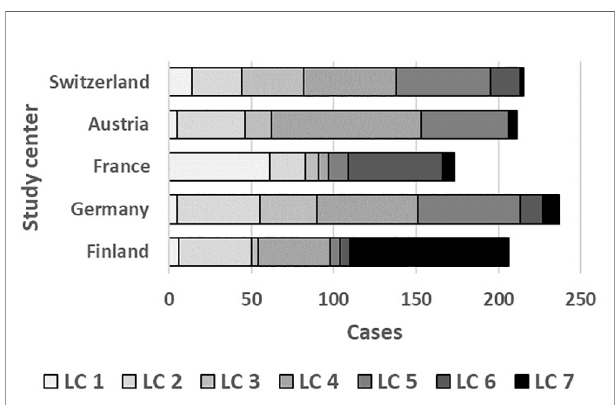
FIGURE 6 | Distribution of latent classes across study centers in PASTURE.